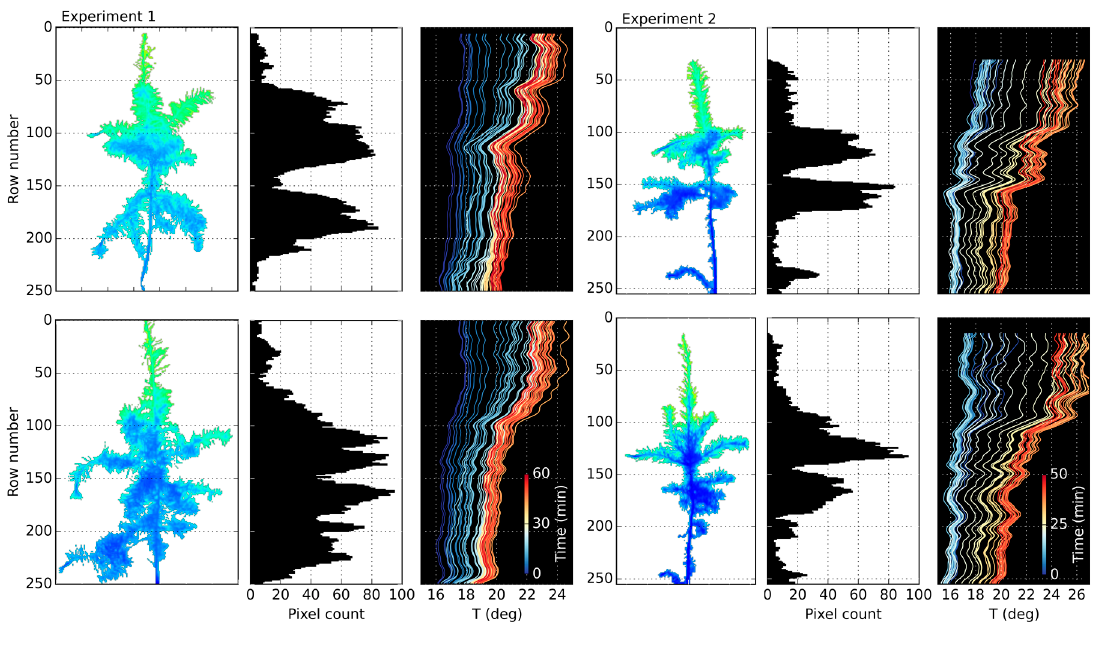
Figure 8. Vertical distribution of canopy temperature over time, retrieved from thermal imagery, for: stressed plant ( top ); and control plant ( bottom ).